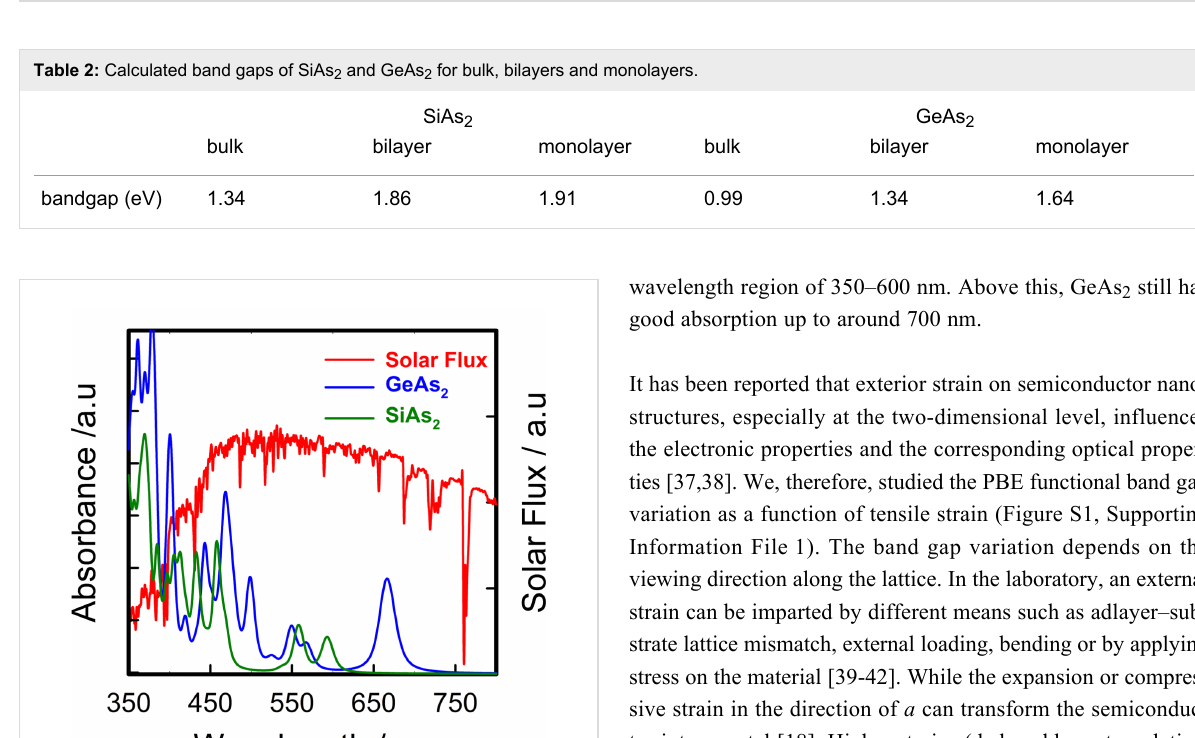
Figure 3: Band structure for SiAs 2 and GeAs 2 calculated by the HSE-Wannier function method. The Fermi level is set as zero. (a–c) Bulk, bilayer and monolayer of SiAs 2 , respectively; (d–f) bulk, bilayer and monolayer of GeAs 2 , respectively.